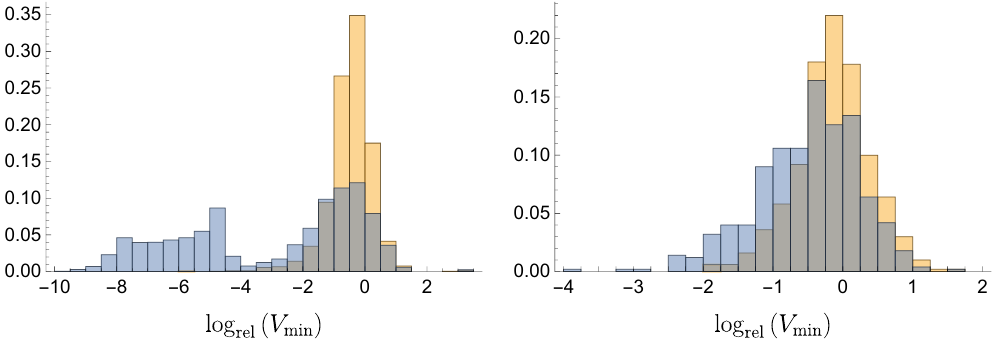
Figure 7 . Logarithmic relative error on V min for 2-vev (left panel) and 3-vev (right panel) manifolds, using the minimisation procedure described in section 3.2 (yellow bars) and its improved version (blue bars), compared to a full-fledged numerical